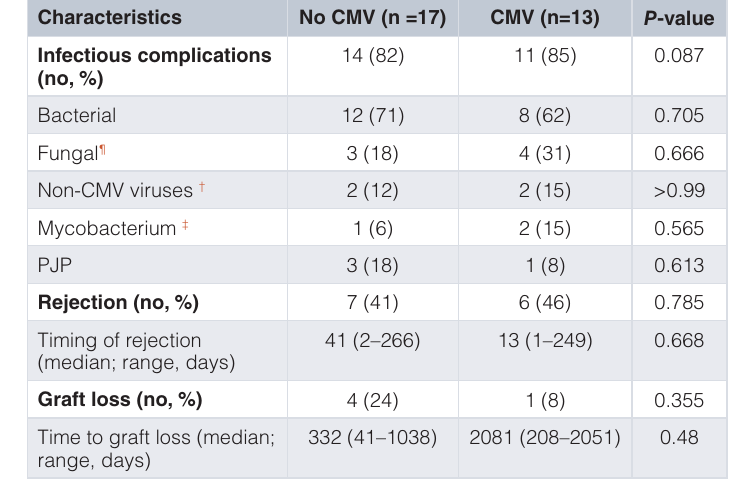
Table 2. Complications among ATG-treated KT recipients (n = 30).